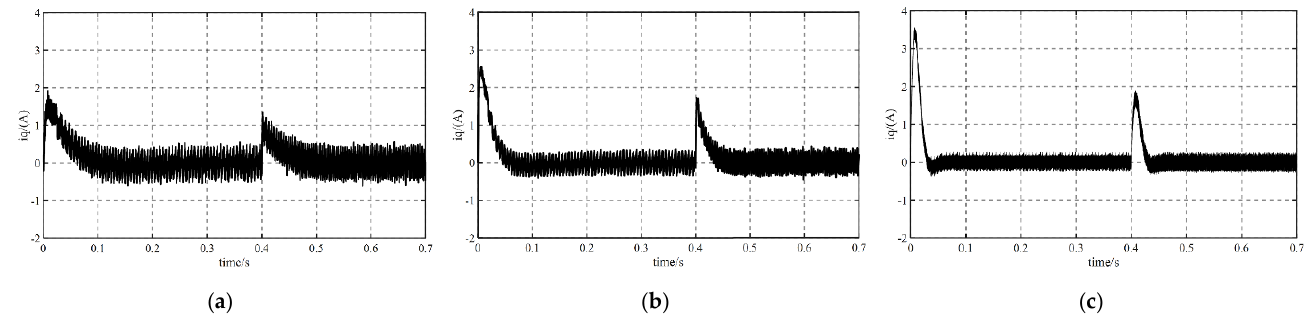
Figure 16. Comparison of the current waveforms of the 3 systems under variable-speed motion: ( a ) PI system; ( b ) SMC system; and ( c ) MPC system.